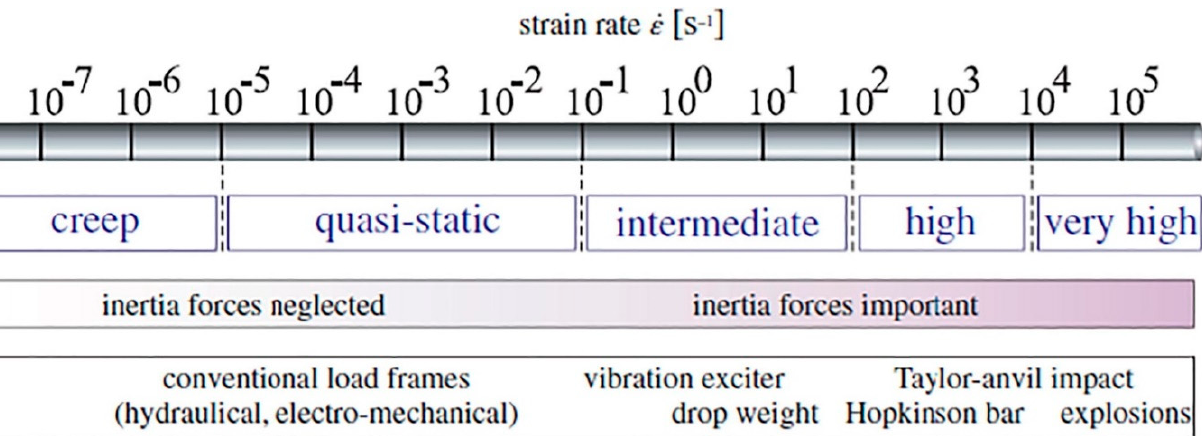
Figure 14. Classifying the strain rate regimes, adapted with permission from Ref. [73]. Copyright © 2021 Elsevier